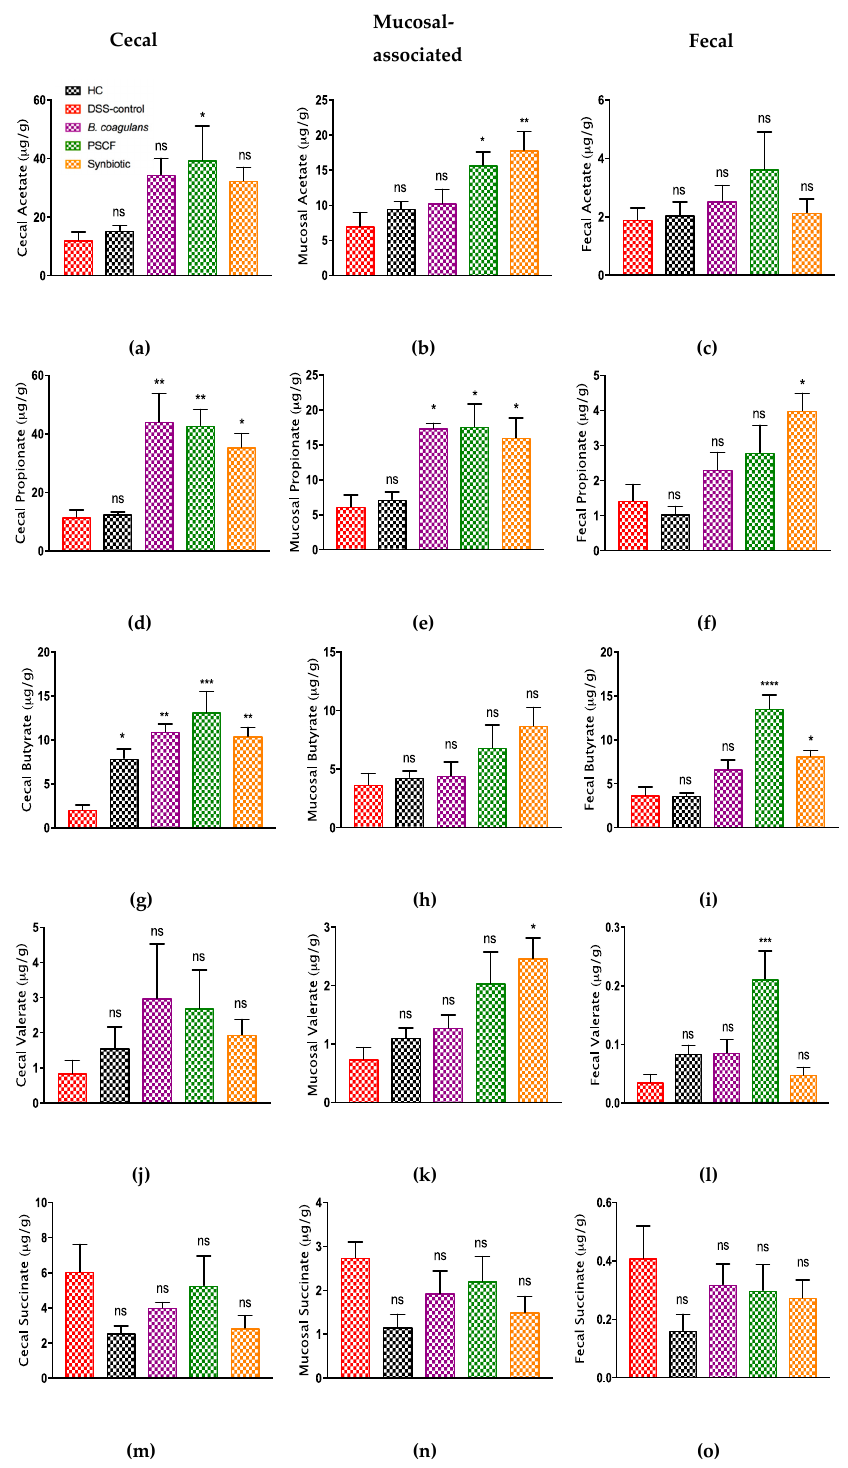
Figure 7. Effects of B. coagulans spores, PSCF and synbiotic in modulating SCFA concentrations in cecal, mucosal-associated and fecal contents in DSS-induced colitis. Cecal- acetate ( a ), proionate ( d ), butyrate ( g ), valerate ( j ), succinate ( m ); mucosal-associated acetate ( b ), proionate ( e ), butyrate ( h ), valerate ( k ), succinate ( n ) and fecal- acetate ( c ), propionate ( f ), butyrate ( i ), valerate ( l ), succinate ( o ). -Statistical significance among groups evaluated by one-way ANOVA followed by Tukey’s test. * p < 0.05, ** p < 0.01, *** p < 0.001, **** p < 0.0001 vs. DSS-colitic group and data expressed as mean ± SEM ( n = 5 per group). ns-non-significant Butyrate levels were significantly decreased by DSS administration (2.05 ± 0.6 μ g/g) compared with that of HC mice (7.91 ± 1.1 μ g/g) in the cecum. The decrease in butyrate induced by DSS was